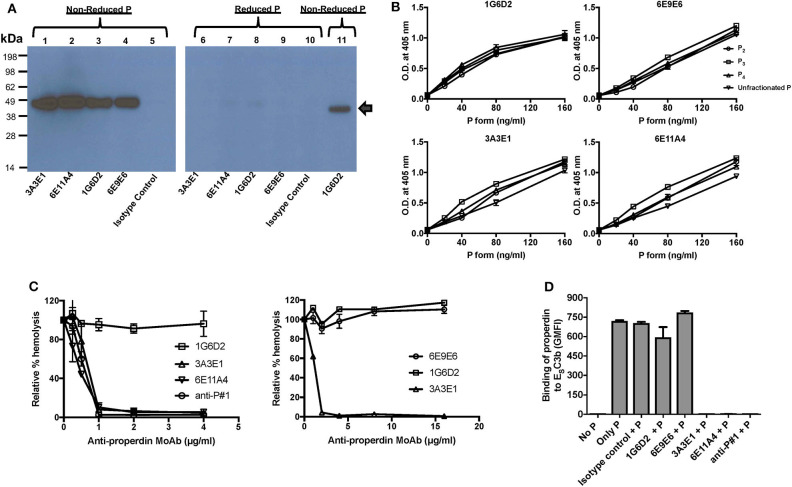
Generation and characterization of anti-properdin MoAbs (3A3E1, 6E11A4, 1G6D2, 6E9E6). (A) Anti-properdin MoAbs recognize non-reduced properdin (P) but not reduced properdin (P). 10 ng of non-reduced or reduced unfractionated properdin was detected with anti-properdin MoAbs 3A3E1, 6E11A4, 1G6D2, or 6E9E6, or purified mouse IgG1 isotype control at 1 μg/ml by immuno Western blot. Binding of the antibodies to non-reduced (lane 1–5, 11) or reduced (lane 6–10) properdin is shown. Lane 11 is a positive control which contains 10 ng of purified properdin detected by 1 μg/mL 1G6D2 anti-properdin MoAb under non-reduced conditions. The arrow indicates the properdin monomer size (~50 kDa). (B) Anti-properdin MoAbs recognize all properdin forms [P2, P3, P4, or unfractionated properdin (P)] in a direct ELISA. The binding was detected as described in “Materials and Methods.” Results are shown as mean and SD of triplicates. (C) 3A3E1 and 6E11A4 inhibit AP-mediated hemolysis of rabbit erythrocytes (ER). ER were incubated with NHS in the presence of one of the indicated anti-properdin MoAbs. The hemolytic activity was determined as described in “Materials and Methods” and was expressed as a relative percentage (%) of hemolysis. Results on the left are shown as mean and SD of duplicate observations. Results on the right are shown as mean and SD of duplicate observations for 6E9E6 and single observations for controls 3A3E1 and 1G6D2. (D) 3A3E1 and 6E11A4 inhibit the ability of properdin to bind to ESC3b. Each anti-properdin MoAb (1G6D2, 6E9E6, 3A3E1, 6E11A4, or anti-P#1) or isotype control was incubated with properdin (P) and ESC3b. The binding of properdin to ESC3b was determined as described in “Materials and Methods.” “No P” was a negative control where no properdin was added, and “Only P” was a positive control where no inhibition antibody was added. The graph is a representative of three independent experiments and is shown as mean and SD of duplicates. The data were analyzed by one-way ANOVA with Dunnett's multiple comparisons against “No P”; p < 0.0001 in “Only P,” “Isotype control+P,” “1G6D2+P,” “6E9E6+P” groups.